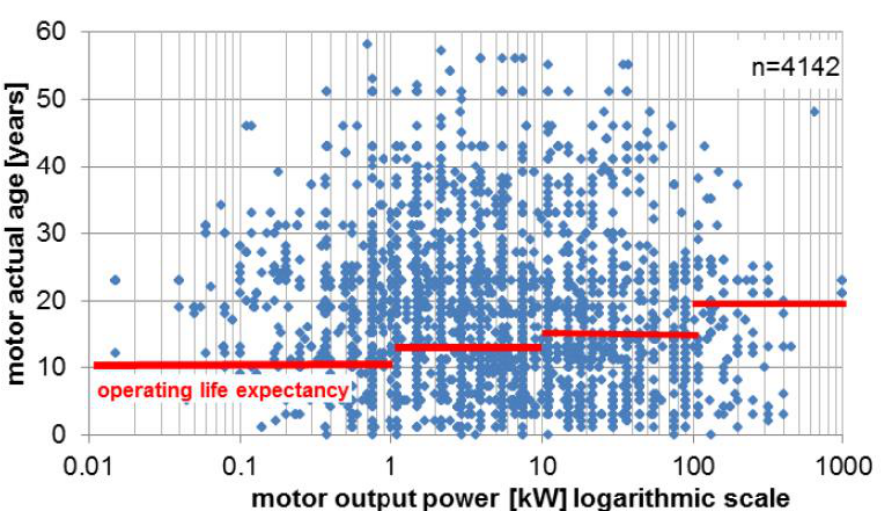
Figure 4. Electric motor age, Switzerland (S.A.F.E. 2013).